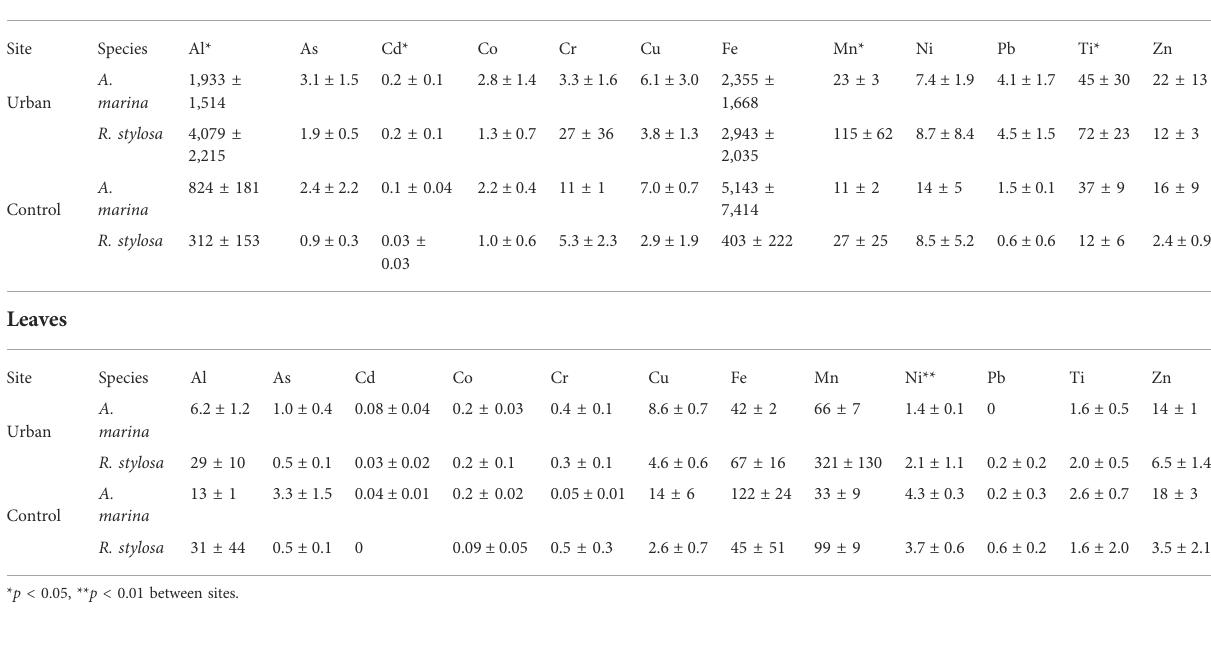
TABLE 2 Mean ± SD TM concentrations in roots and leaves in mg kg − 1 at both sites for both mangrove species. Roots